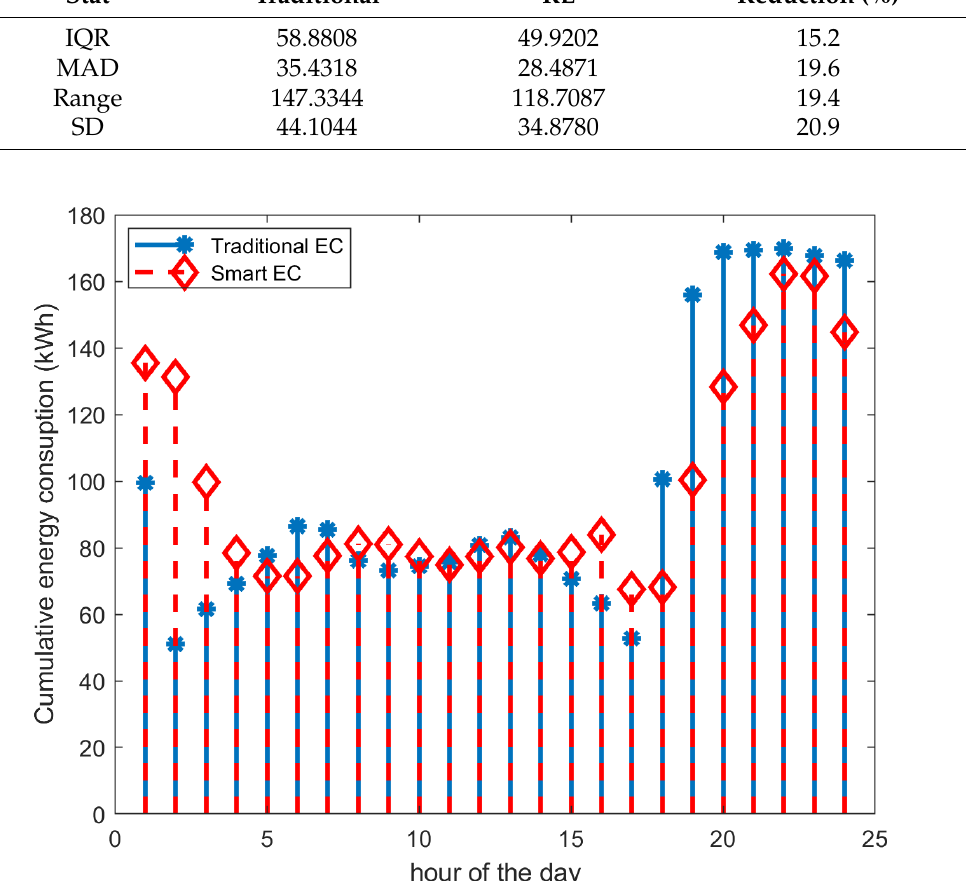
Figure 5. The mean of the cumulative energy consumption of 100 homes over 100 random snapshots: Traditional and Reinforcement Learning. The RL approach succeeded in shaving the peaks and levelling the